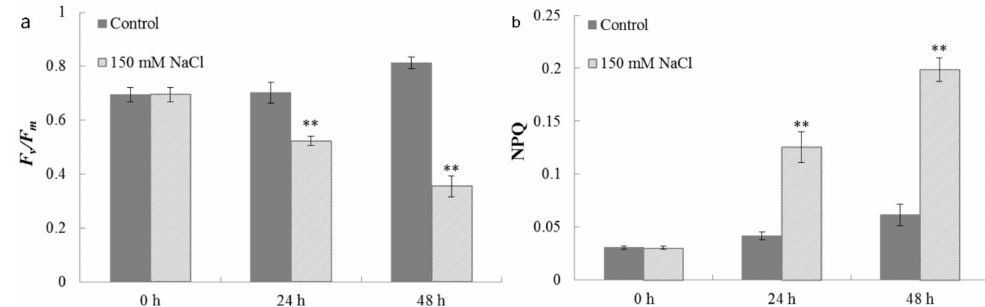
Figure 8. The effects of salt stress on (a) the maximum photo-chemical efficiency ( F v / F m ) and (b) non-photochemical quenching co-efficiency (NPQ) of C. reinhardtii . Cell samples harvested after 0, 24, and 48 h cultivation from both the salt treatment and the control, were used for measurements of F v / F m and NPQ. Each value is the mean ± SD of three biological replicates. Asterisks indicate statistical significance (* 0.01 < p < 0.05, ** p < 0.01) between control and salt-treated cells according to the Tukey’s